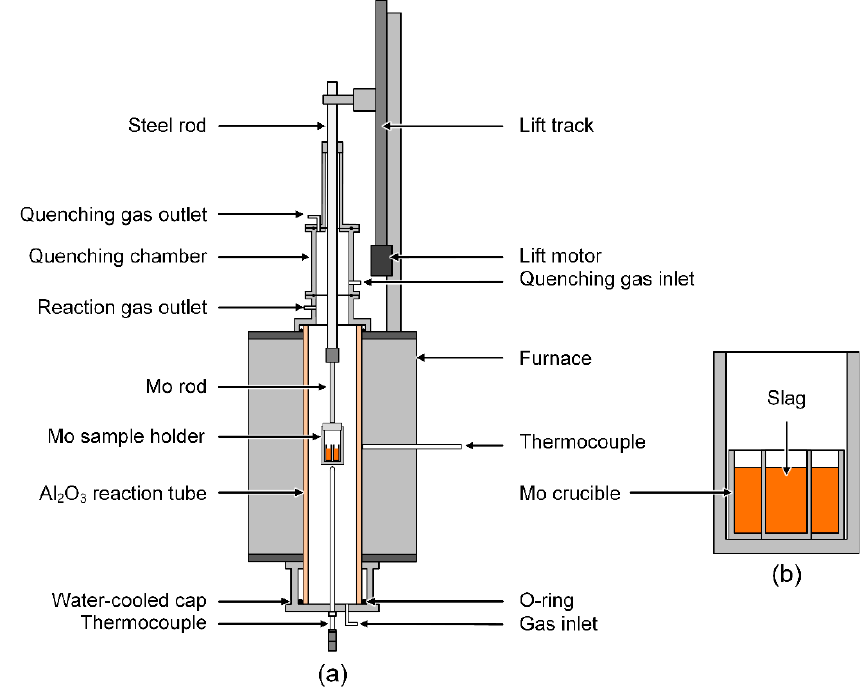
Figure 1. Experimental setup: ( a ) Furnace; ( b ) sample holder with crucibles.